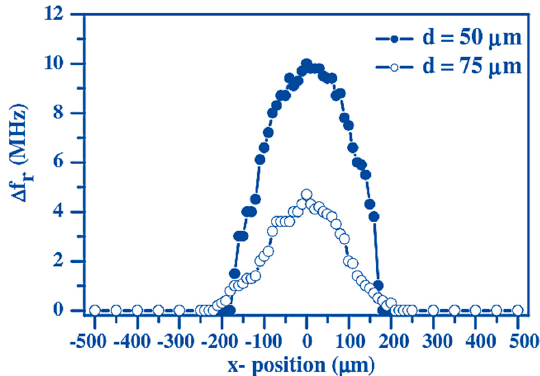
Figure 5. Measured reflection parameter S 11 versus frequency above faultless metal and above a 200- µ m-wide notch for a probe-to-metal distance d = 50 µ m (from [29]; copyright © 2008; redesigned with permission).